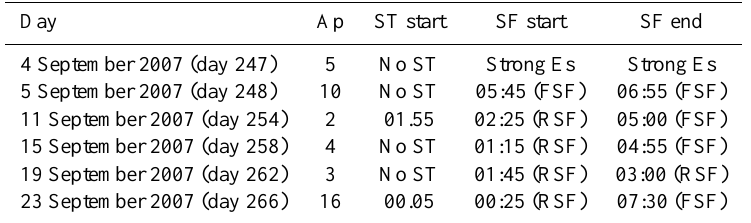
Table 2. UT start and end of spread-F at Palmas on September 2007. Day Ap ST start SF start SF end Strong Es Strong Es